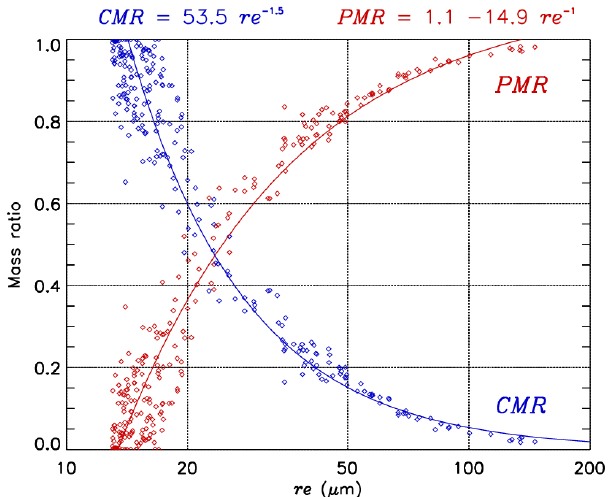
Figure 5. Effective radius of cloud particles ( r e ) vs. cloud mass ratio (CMR) indicated by blue dots and precipitation mass ratio (PMR) indicated by red dots for cloud passes where r e > 13µm. The blue line indicates the best fit for measurements of CMR as a function of r e (the equation is indicated in blue at the top of the graph). The R 2 from this fit function is 0.97. The red line indicates the best fit for measurements of PMR as a function of r e (the equation is indicated in red at the top of the graphic). The R 2 from the fit function of r e − PMR is 0.93. The number of cloud passes in this analysis is